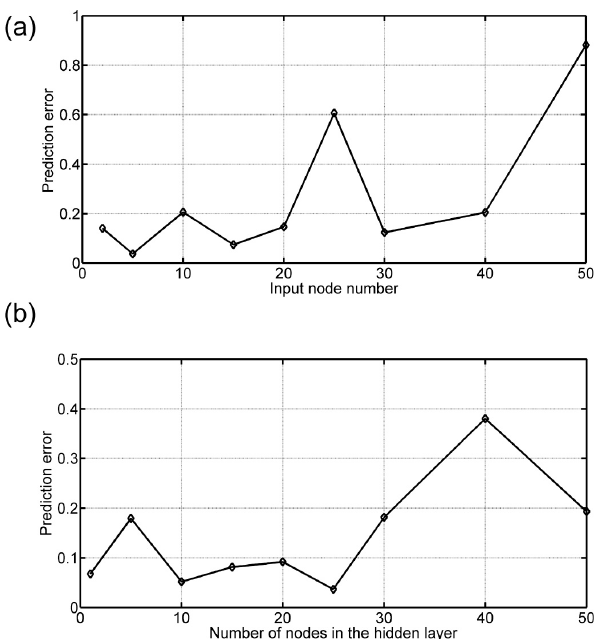
Fig. 6. Errors in the prediction of the system with different network architectures for synthetically generated chaotic (B = 3.8), autore- gressive (A = 0.5) and random model (a) errors of predictions of the system with different number of input nodes. (b) Errors of the system with different numbers of hidden layer node.